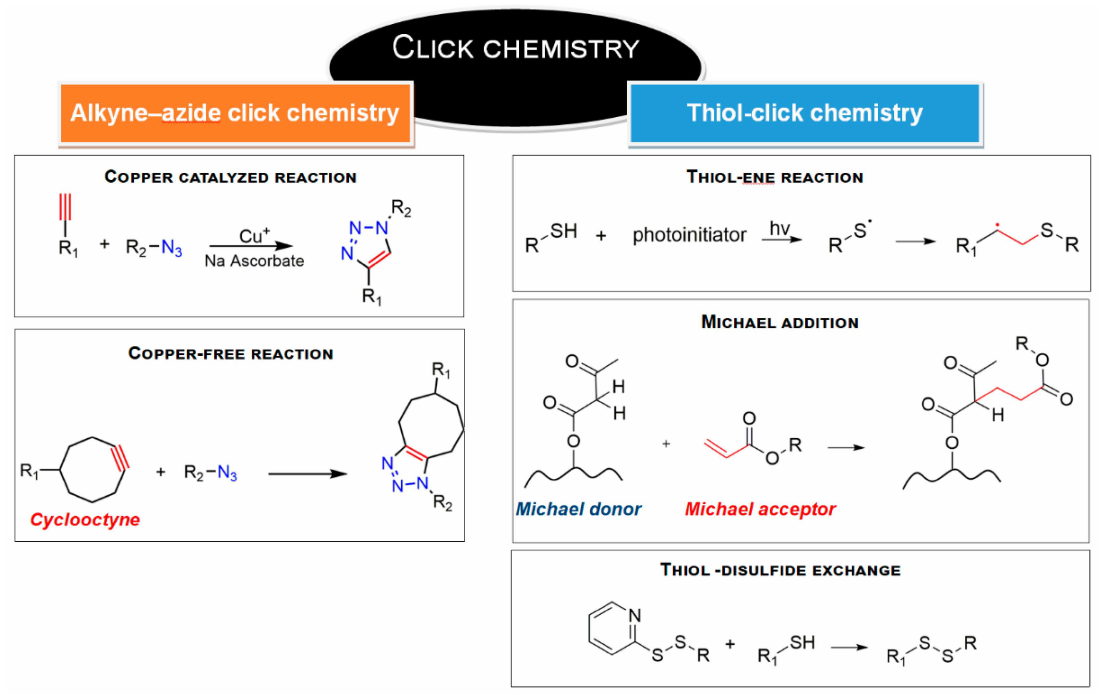
Figure 4. Click chemistry reactions involved in NG